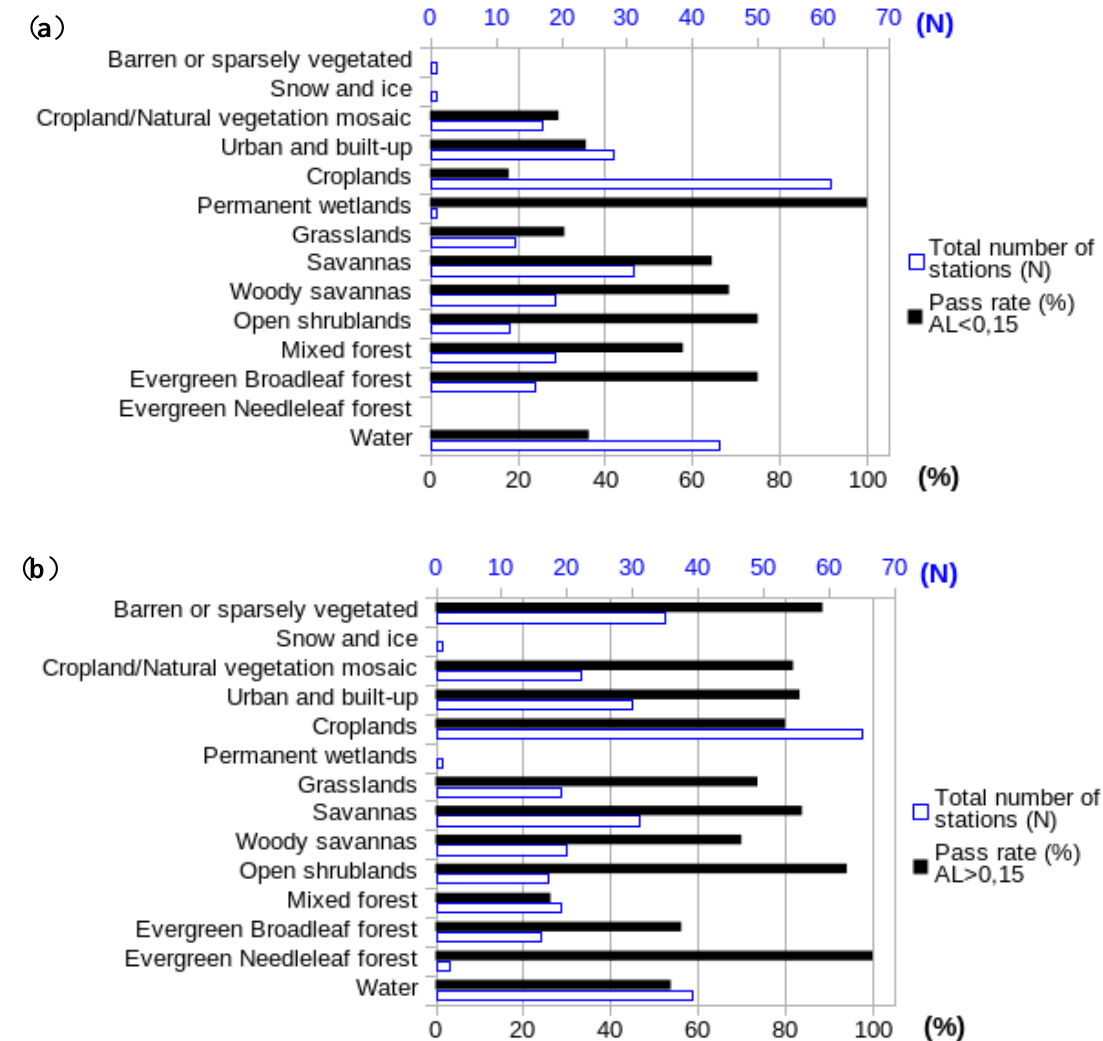
Figure 8. Pass rate per land cover type from the MODIS Land Cover product. Results are given for the two regimes of albedo values: ( a ) Lower than 0.15; and ( b ) bigger than 0.15.